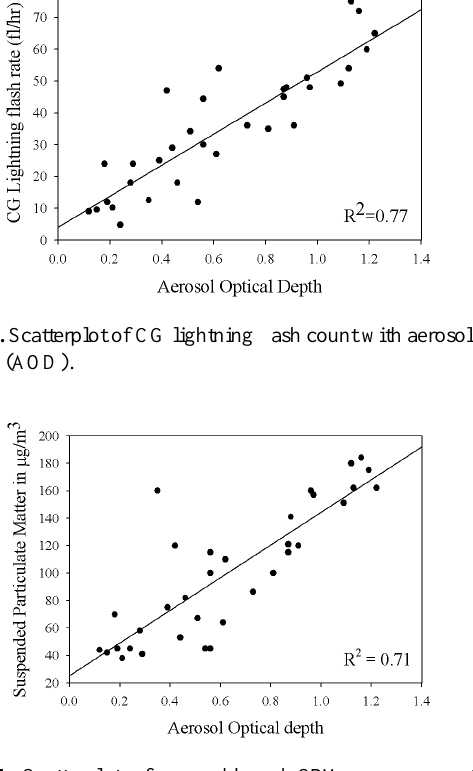
Figure 7. Scatterplot of ground-based SPM measurement and satellite-based AOD